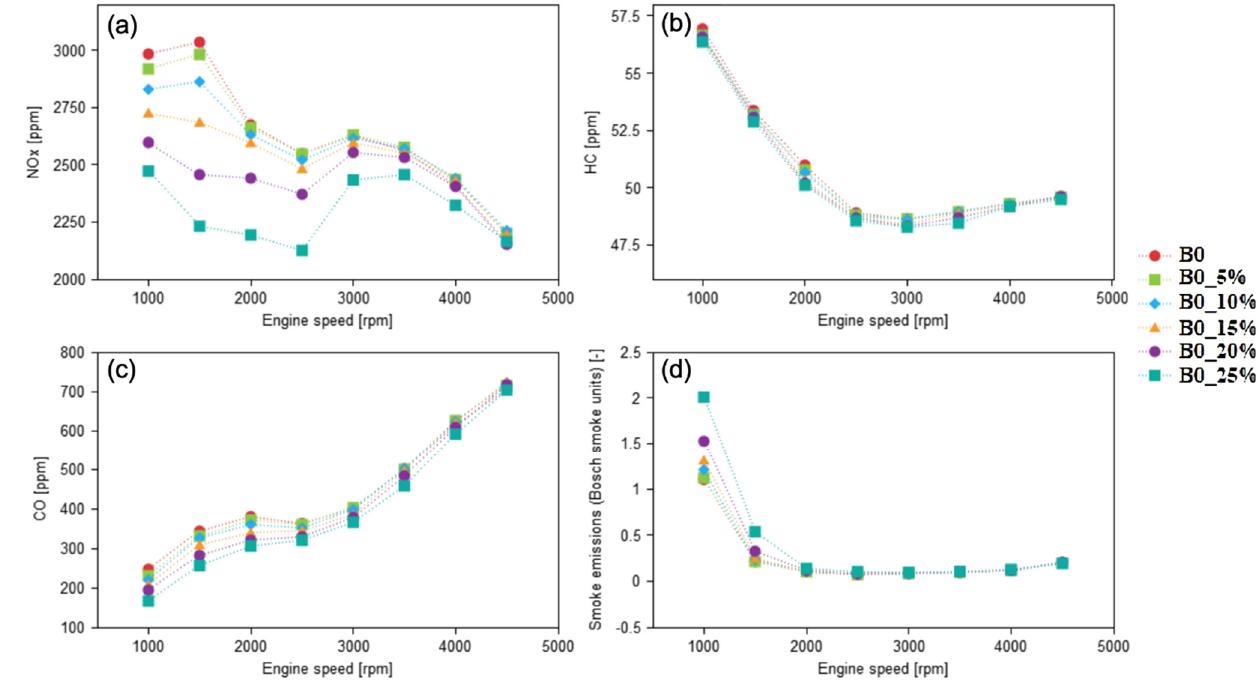
Figure 6. Comparison of emissions ( a ) 𝑁𝑂 𝑥 , ( b ) 𝐻𝐶 , ( c ) 𝐶𝑂 , and ( d ) soot, for B0 LIVC operation.